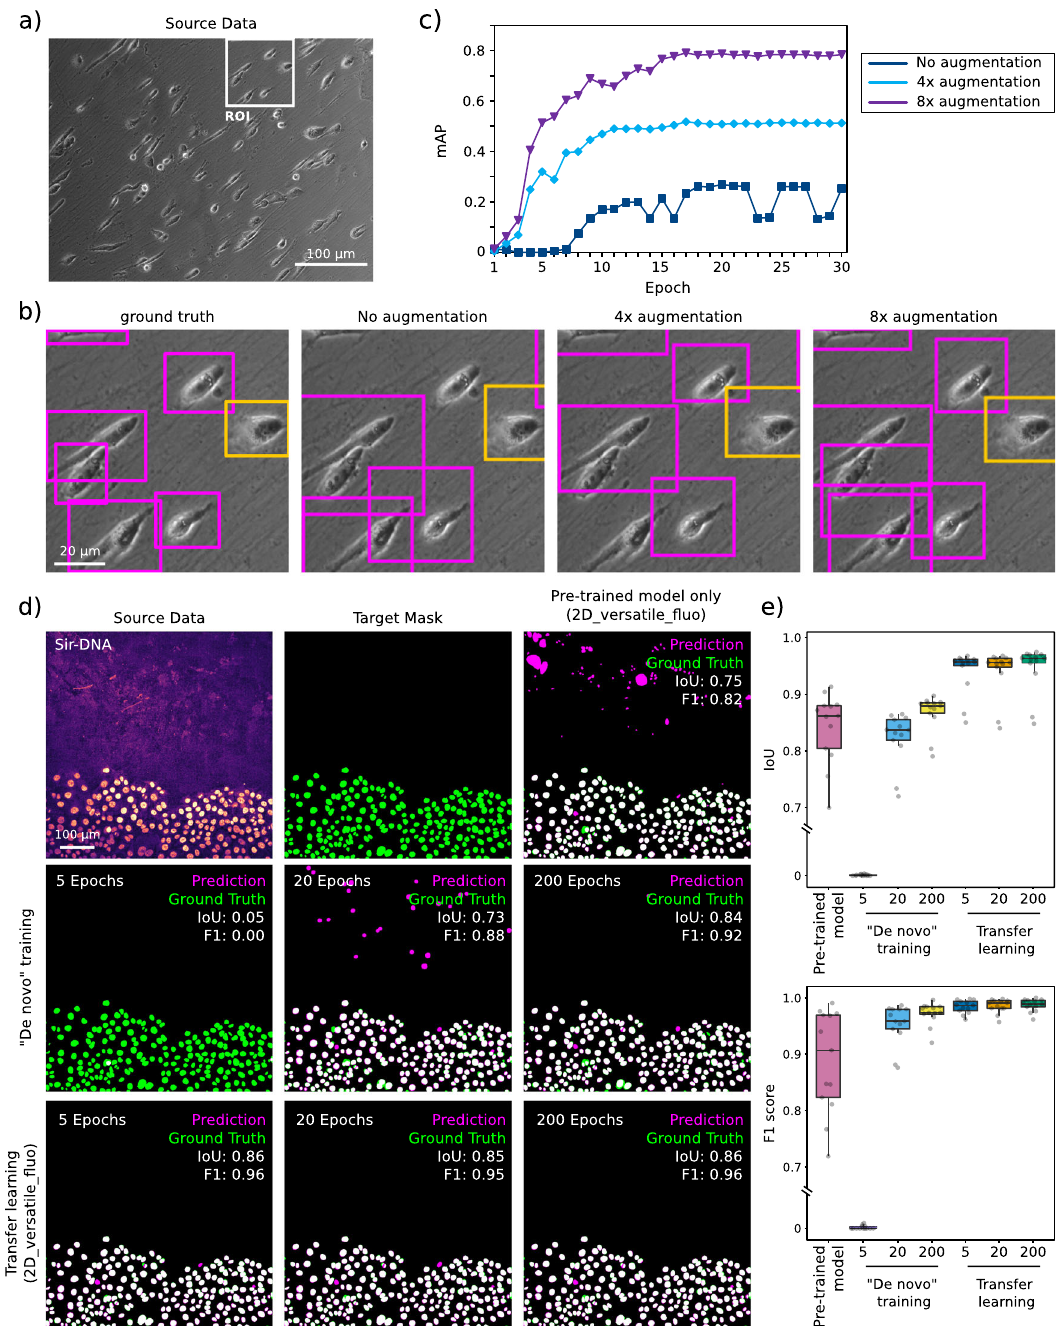
Fig. 9 Data augmentation and Transfer learning can improve performance. a – c Data augmentation can improve prediction performance. YOLOv2 cell shape detection applied to bright- fi eld time-lapse dataset. a Raw bright- fi eld input image. b Ground-truth and YOLOv2 model predictions (after 30 epochs) with increasing amounts of data augmentation. The original dataset contained 30 images which were fi rst augmented by vertical and horizontal mirroring and then by 90° rotations. c mAP (mean average precision) as a function of epoch number for different levels of data augmentation. d , e These panels display an example of how transfer learning using a pretrained model can lead to very high-quality StarDist prediction even after only 5 epochs. This fi gure also highlights that using a pretrained model, even when trained on a large dataset, can lead to inappropriate results. d Examples of StarDist segmentation results obtained using models trained using 5, 20 or 200 epochs and using a blank model ( “ De novo ” training) or the 2D-versatile- fl uo as a starting point (transfer learning). e StarDist QC metrics obtained with the models highlighted in ( d ) ( n = 13 images). The IoU (intersection over union) scores are calculated over the whole image, while the F1 scores are calculated on a per-object basis. Results are displayed as boxplots which represent the median and the 25th and 75th percentiles (interquartile range); outliers are represented by dots 96 . Note that the axes of both graphs are cut. Source data for panel ( c ) and ( e ) are provided in the Source Data fi